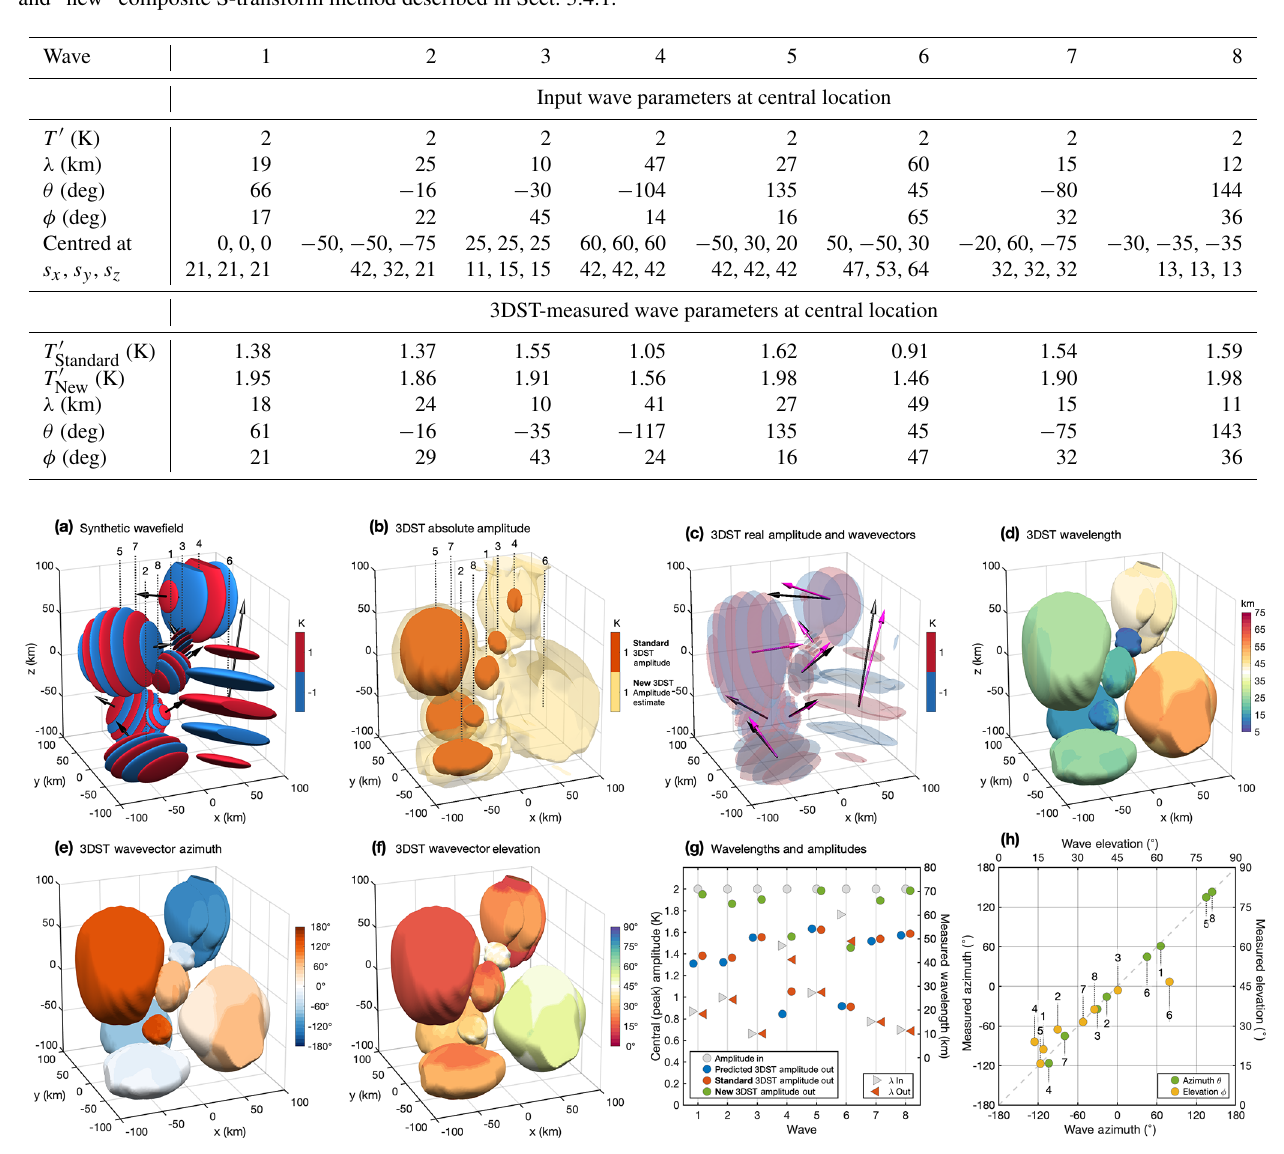
Figure 3. Results of 3-D Stockwell transform (3DST) analysis of a synthetic wavefield. Panel (a) shows temperature perturbations of the input wave packets, with isosurfaces evaluated at ± 1K and black arrows indicating the direction of phase propagation. Absolute 3DST- measured wave amplitudes | A (x,y,z) | are shown in panel (b) , where orange and yellow isosurfaces are drawn at 1K for the “standard” and “new” 3DST amplitude measurement methods respectively, as described in Sect. 3.4.1. Real 3DST-measured temperature perturbations (cid:60) (cid:2) A (x,y,z) (cid:3) from the new method are shown in panel (c) , where black (pink) arrows indicate the true (measured) direction of phase propagation. Panels (d) , (e) and (f) show 3DST-measured wavelengths, wavevector azimuths and elevations relative to the positive y axis and x,y plane respectively, evaluated on 1K isosurfaces. Coloured grey circles in panel (g) show the central (maximum) input temperature amplitudes for each wave packet, with blue, orange and green coloured circles showing the predicted, standard and new 3DST-measured wave amplitudes at the centre of each wave packet respectively. Input and 3DST-measured wavelengths evaluated at the centre of each wave packet are shown by grey and orange triangles. Finally, panel (h) shows input versus 3DST-measured azimuth (green circles) and elevation (yellow circles) evaluated at the centre of each wave packet. The values in panels (g) and (h) are also listed in Table 1. For more details, see Sect.